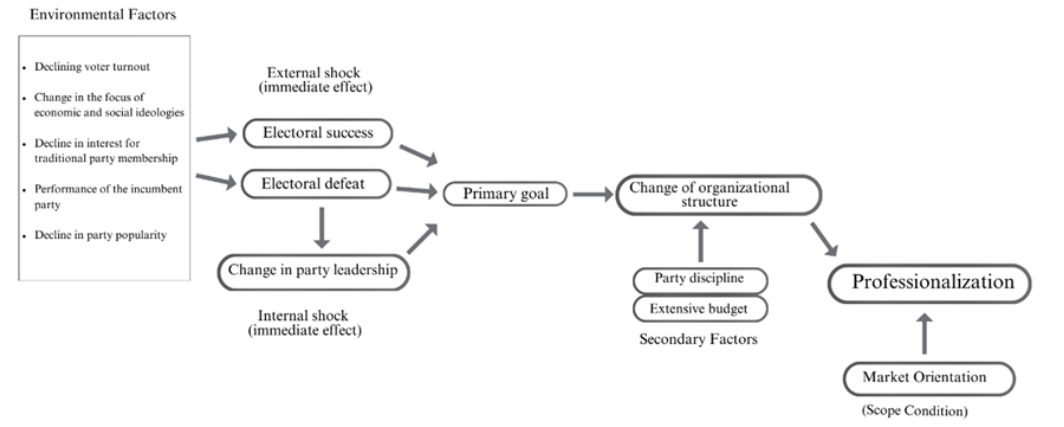
Figure 1: Proposed Causal Mechanism of Professionalization of Political Campaign (Source: Author‘s